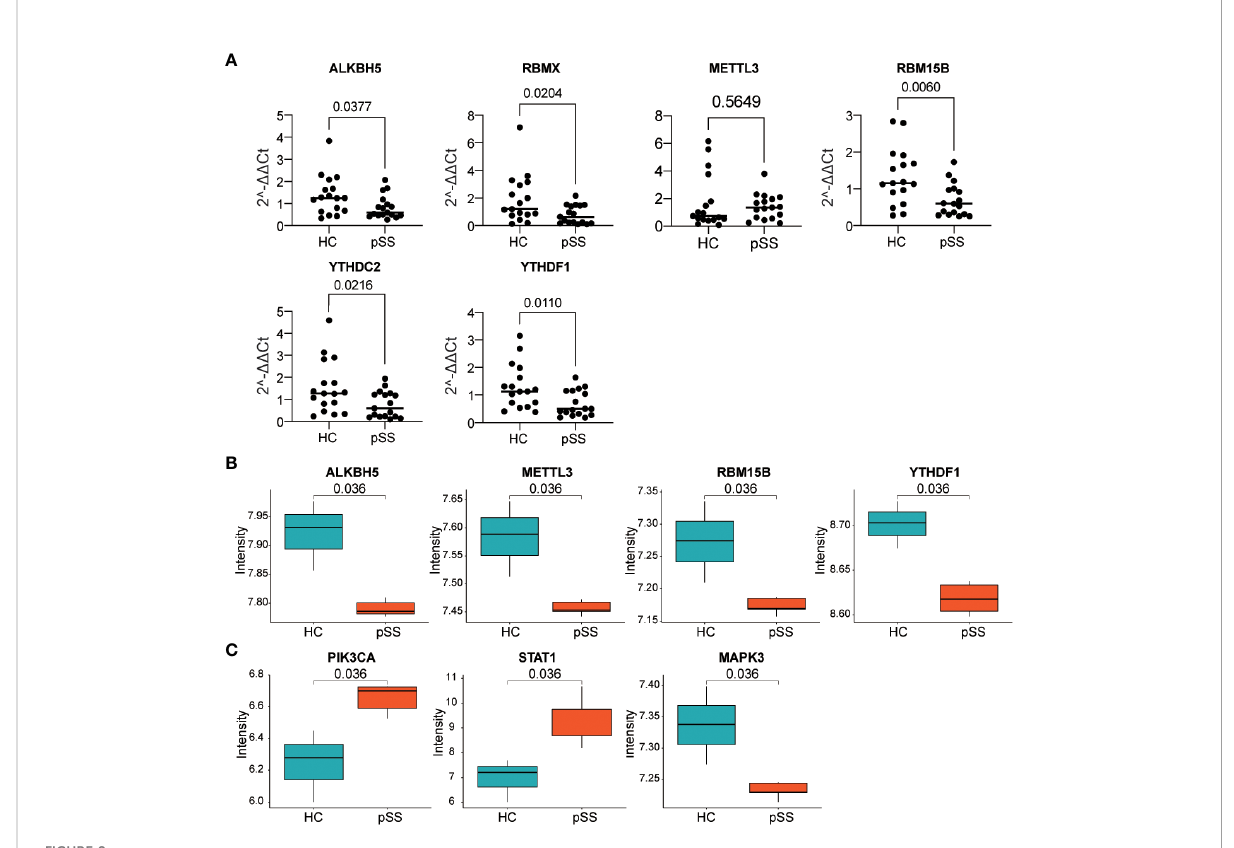
FIGURE 8 Veri fi cation of gene expression in our PB samples and labial salivary glands. (A) Veri fi cation of DEMRs in PB samples of our cohort. (B, C) Veri fi cation of DEMRs (B) and autophagy hub genes (C) in labial salivary glands of dataset